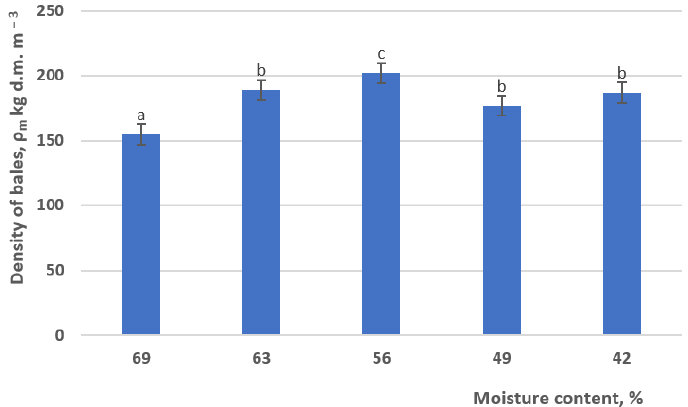
Figure 4. Bar chart of balage density in bales at different moisture content levels at a pressing pressure of 14 MPa and plant material at a length of 312 mm. Different lowercase letters indicate a statistically significant difference at p ≤ 0.05. d.m., dry matter.